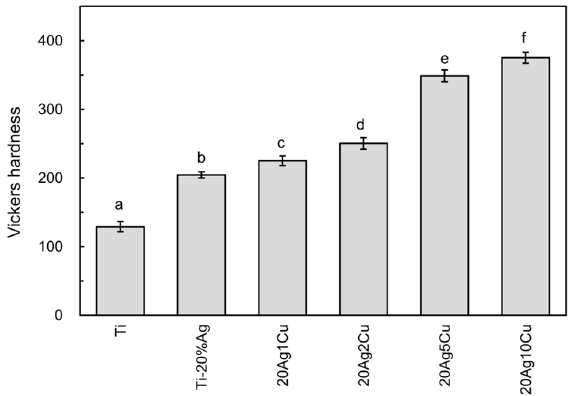
Figure 4. The Vickers hardness of the Ti-Ag-Cu alloys. Identical letters indicate a statistically insignificant difference ( p > 0.05).